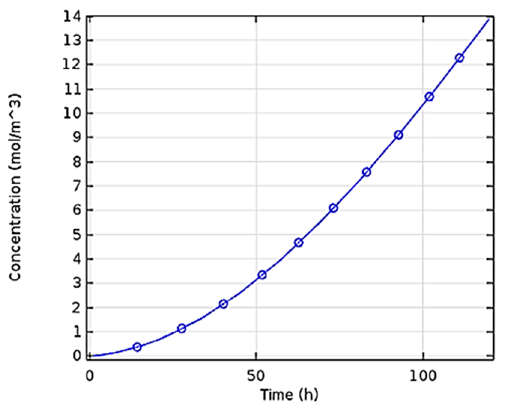
Figure 5. Changes in the concentration of biomass with time.